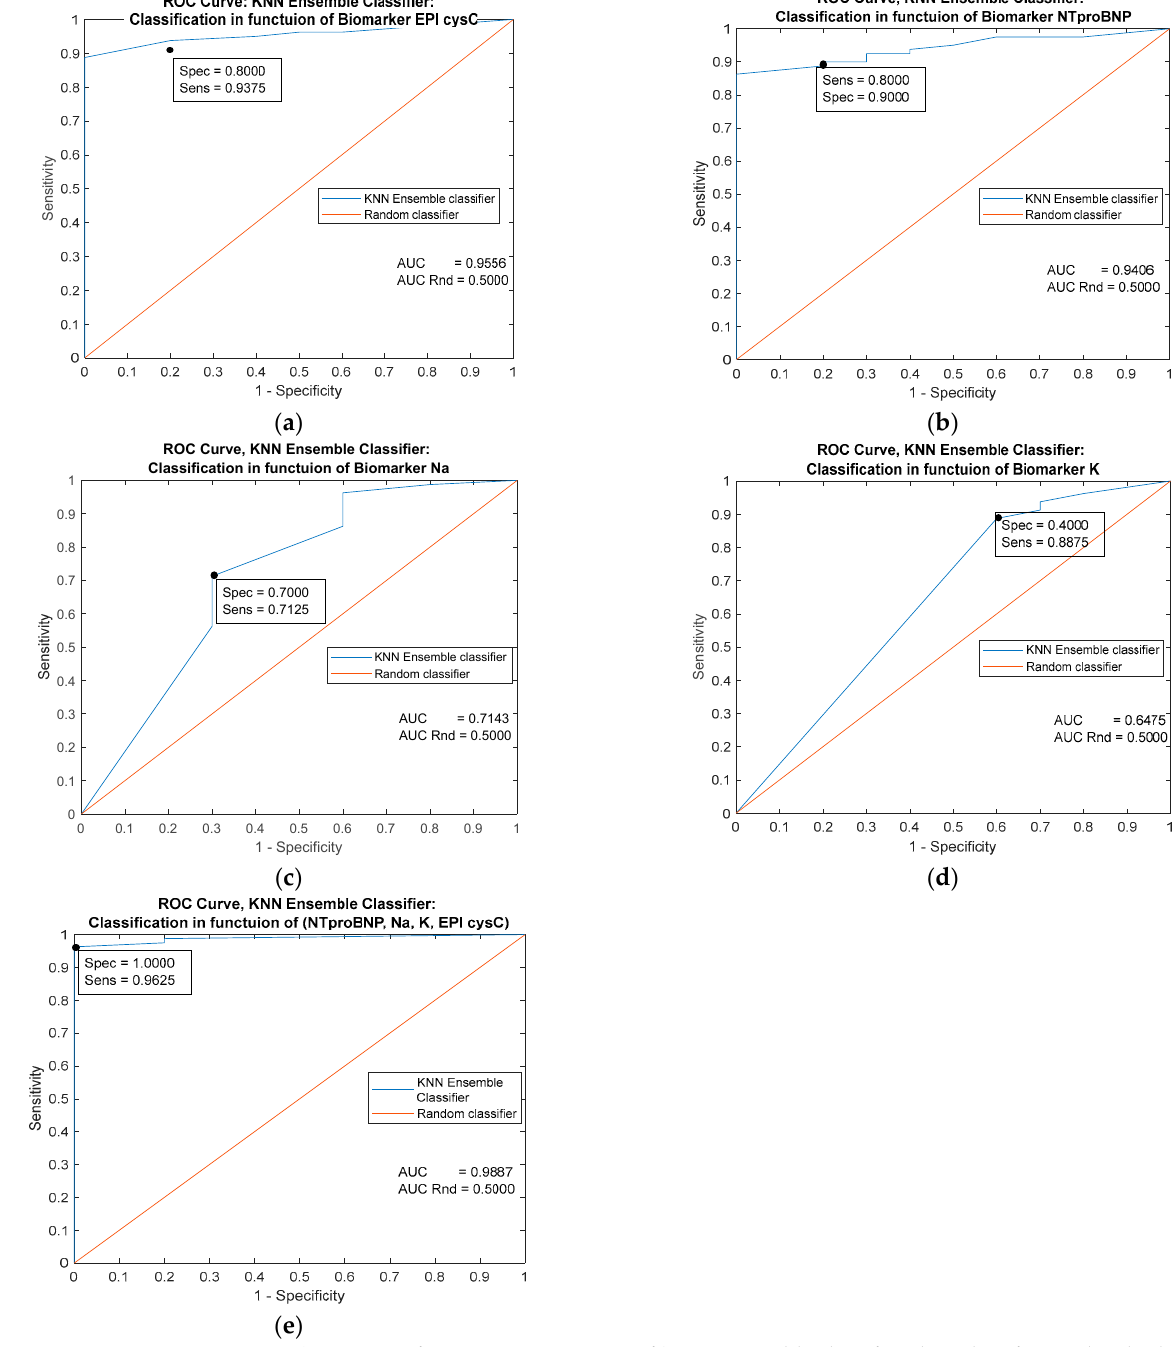
Figure 5. Performance comparison of k -NN ensemble classifiers based on four individual predictors ( a – d ) and on the combination of all the mentioned predictors ( e ). The greatest single prognostic significance has the biomarker EPI cysC Figure 6a (AUC = 0.8562). The classifier based on the combination of all examined markers has a weaker performance Figure 6e (AUC = 0.8187) compared with the other classifiers. The variables Na and K Figure 6c,d have no prognostic significance in the case of the Bayes classifier and behave identically to the random